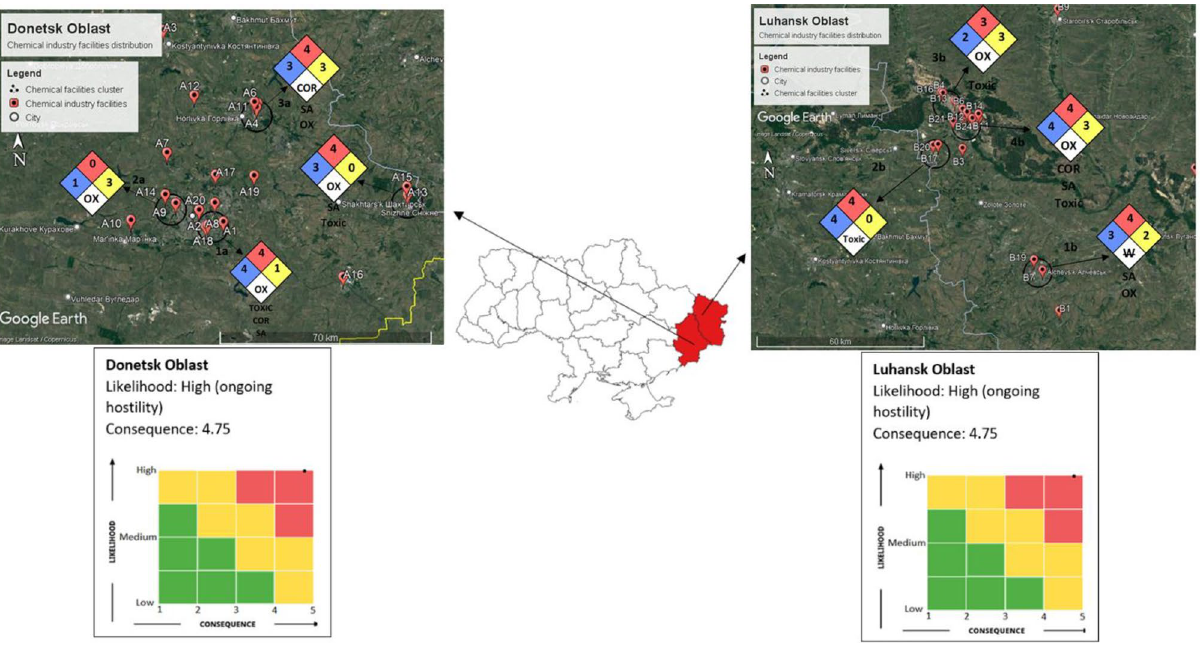
Figure 18. Chemical industry disaster risk assessment and risk metrics in Eastern